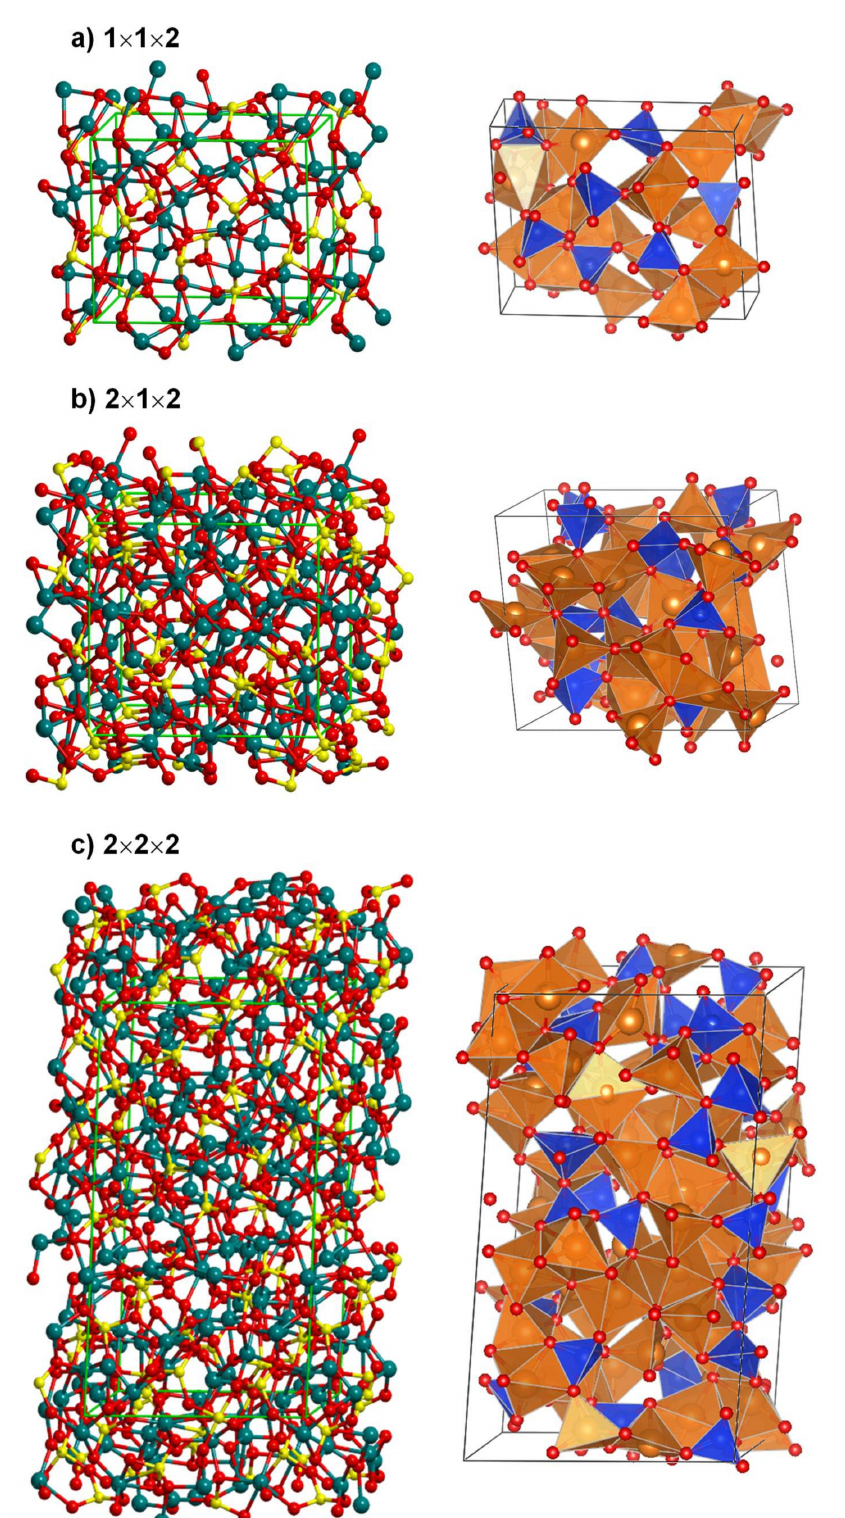
Figure 8. B3LYP-optimized structures of the bulk Mg 2 SiO 4 adopting the 1 × 1 × 2 ( a ), 2 × 1 × 2 ( b ), and 2 × 2 × 2 ( c ) super-cell configurations generated by classical MD simulations at T = 1800 K, both in the atomistic views (left) and in the polyhedral forms